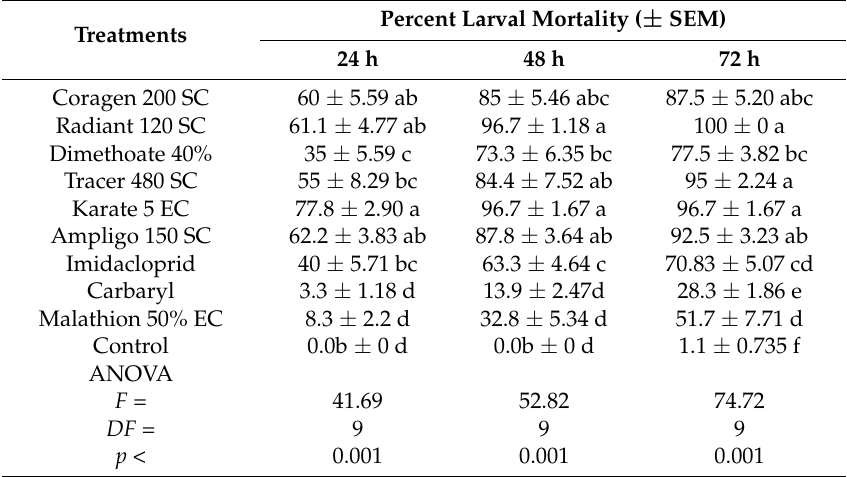
Table 3. Mean percentage ( ± SEM) of cumulative mortality of FAW larvae at 24, 48, and 72 h after application of synthetic insecticides in a laboratory test.